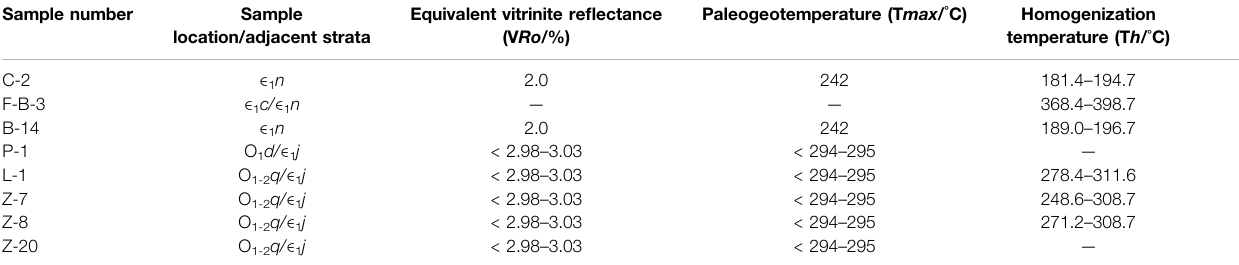
TABLE 1 | The homogenization temperature and equivalent vitrinite re fl ectance of samples.